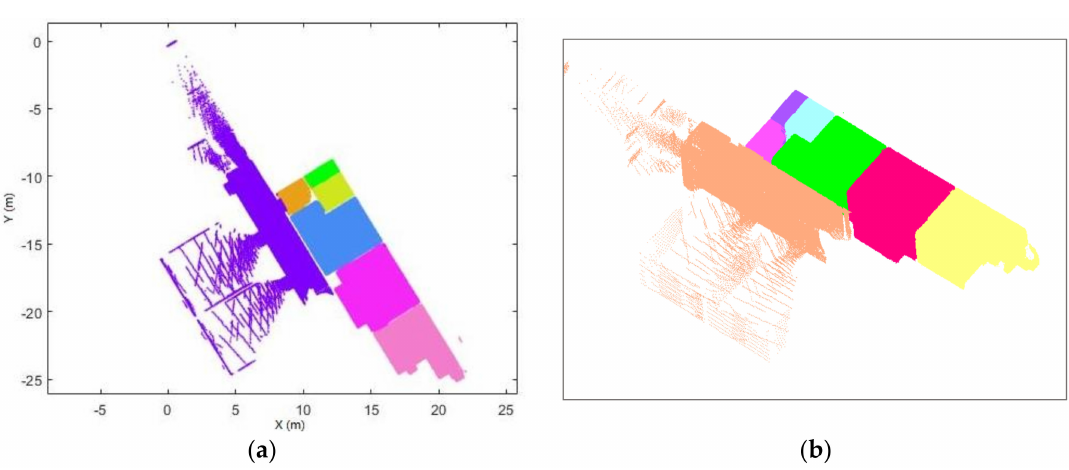
Figure 23. Space subdivision result in 2D ( a ) and 3D ( b ) view (different space shown in different